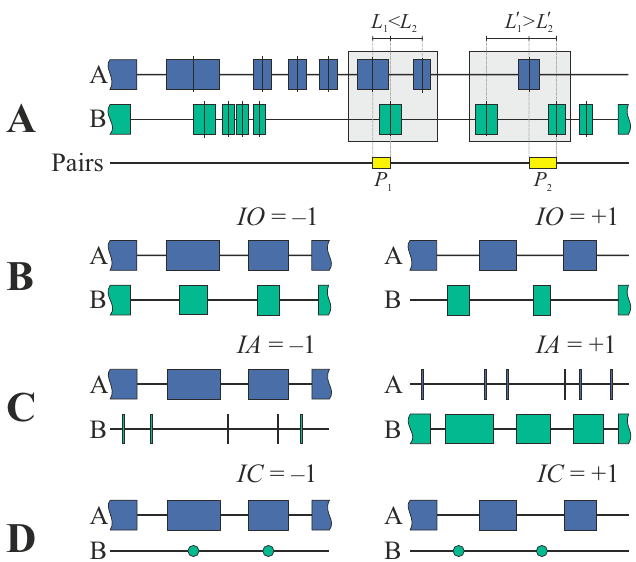
Figure 1. ( A ) Definition of the nearest neighbors between the stretches of two types, A and B. The positions of stretches over the genome and the distances between the stretches are defined by the centers of the stretches. The pairs for analysis of correlations were chosen as the nearest neighbors in the combinations ABA and BAB. ( B – D ) Indices for the analysis of mutual stretch characteristics. ( B ) Index of overlapping (Equation (1)) is equal to − 1 if the centers of A- and B-stretches coincide with each other (complete colocalization). For remote non-overlapping stretches (absence of colocalization), the index of overlapping tends towards +1. ( C ) Index of asymmetry (Equation (2)) characterizes the difference in the distributions of stretch lengths. If the A-stretches are much shorter in comparison to B-stretches, the index of asymmetry is equal to − 1, whereas if the A-stretches are much longer than the B-stretches, it tends towards +1. ( D ) Index of coverage (Equation (3)) is equal to − 1 if the centers of A-stretches and positions of B-points coincide with each other (complete colocalization). For remote non-overlapping positioning (absence of colocalization), the index of coverage tends towards